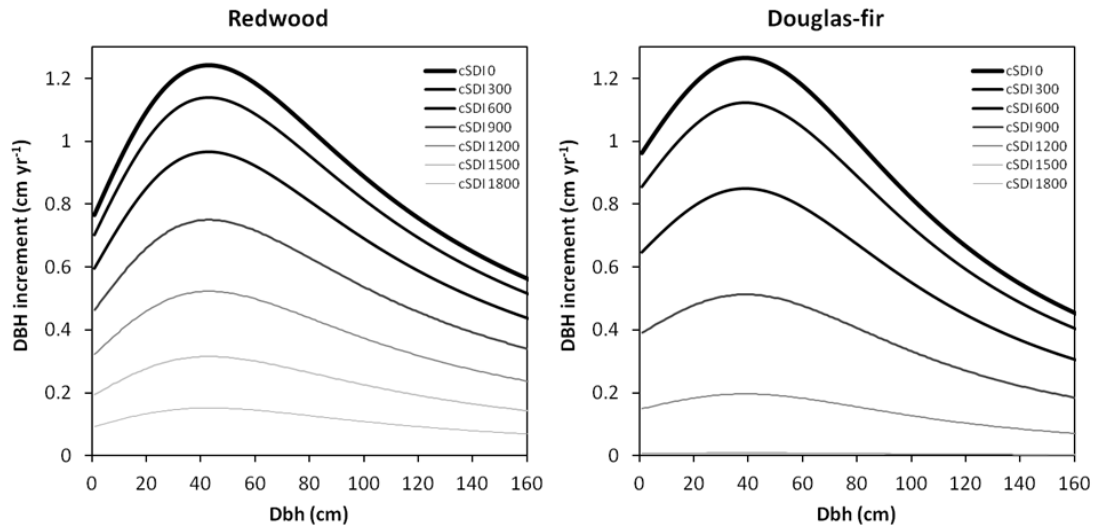
Figure 3. Relationship between expected (average) annual dbh increment (cm year −1 ) and dbh (cm) in redwood and Douglas-fir at Headwaters Forest Reserve, California, as a function of competitive SDI (cSDI) and crown ratio predicted from